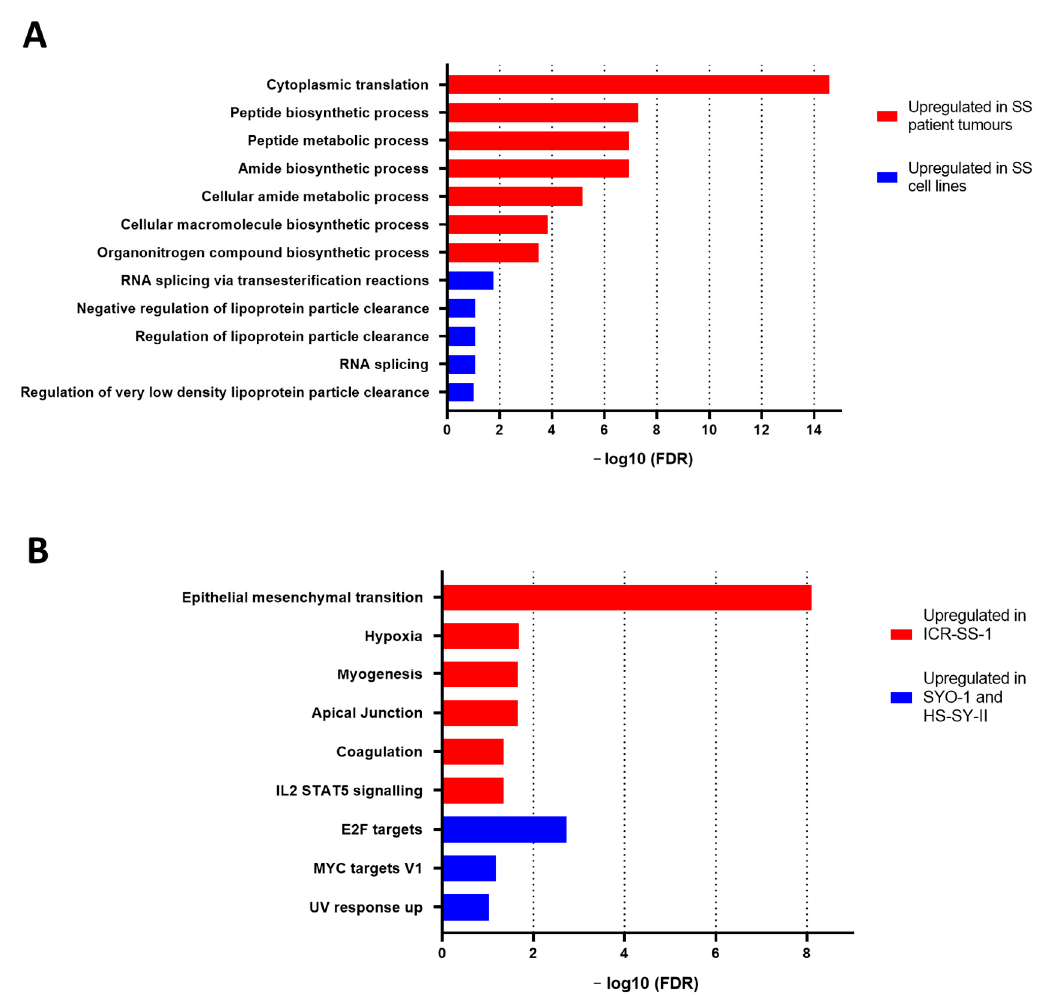
Figure 5. ( A ) Over-representation analysis plot showing biological processes that are upregulated in synovial sarcoma (SS) patient tumours samples (red) and in cell lines (blue) after mutual comparison. ( B ) Over-representation analysis plot showing hallmark pathways upregulated in ICR-SS-1 (red) and in SYO-1 with HS-SY-II (blue) after mutual comparison. FDR is false discovery rate.